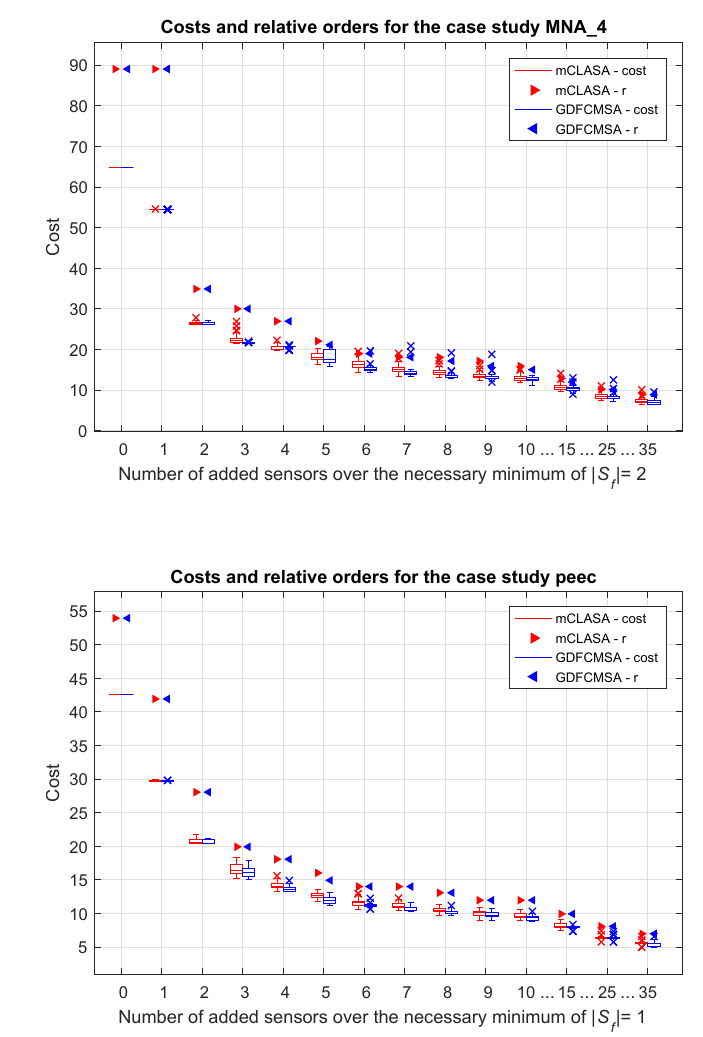
Figure 5. The values of the cost functions and relative degrees with regard to the number of added sensors in the case studies MNA_4 and peec. The box plots show the interquartile ranges and the medians of the cost functions, while the scatter plots visualize the minimum value of the relative order for 100 independent runs. For each value of the x -axis, the results provided by the mCLASA are presented on the left-hand side, while the results provided by the GDFCMSA algorithm are shown on the right-hand side. The triangles denote the relative orders, while the plus signs represent the outliers of the corresponding